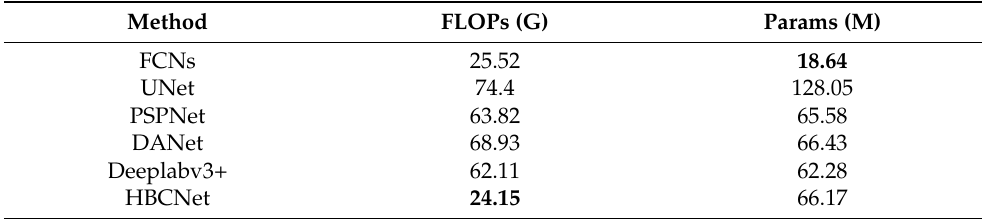
Table 8. Comparisons of model complexity between HBCNet and other networks. The values in bold are the